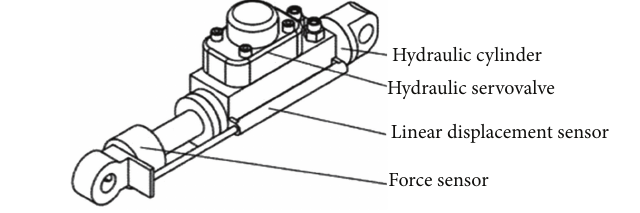
Figure 2: Linear hydraulic servocylinder.